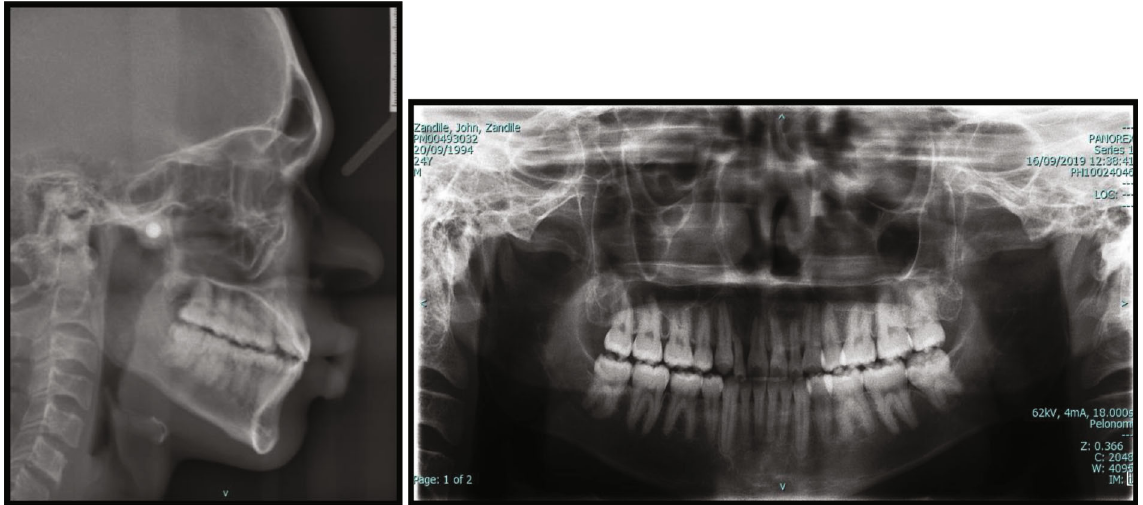
Figure 5: Posttreatment